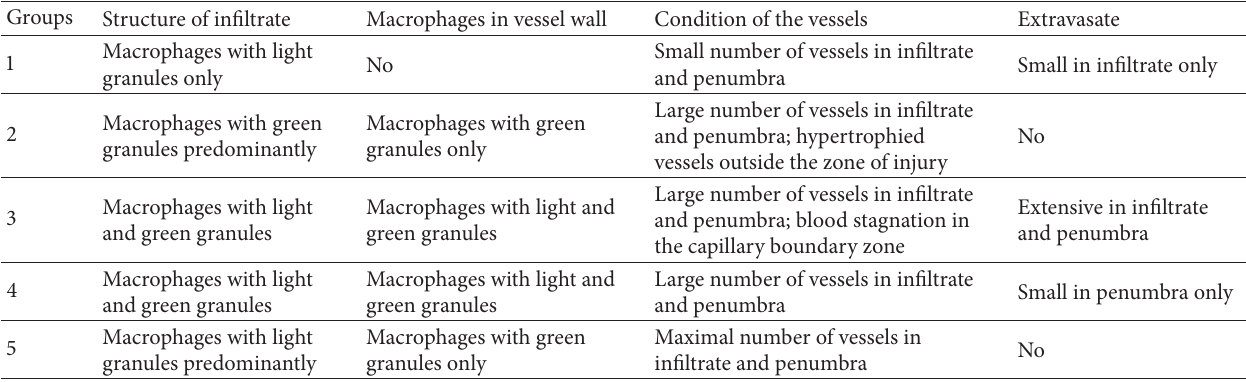
Table 3: Morphological characteristic groups with